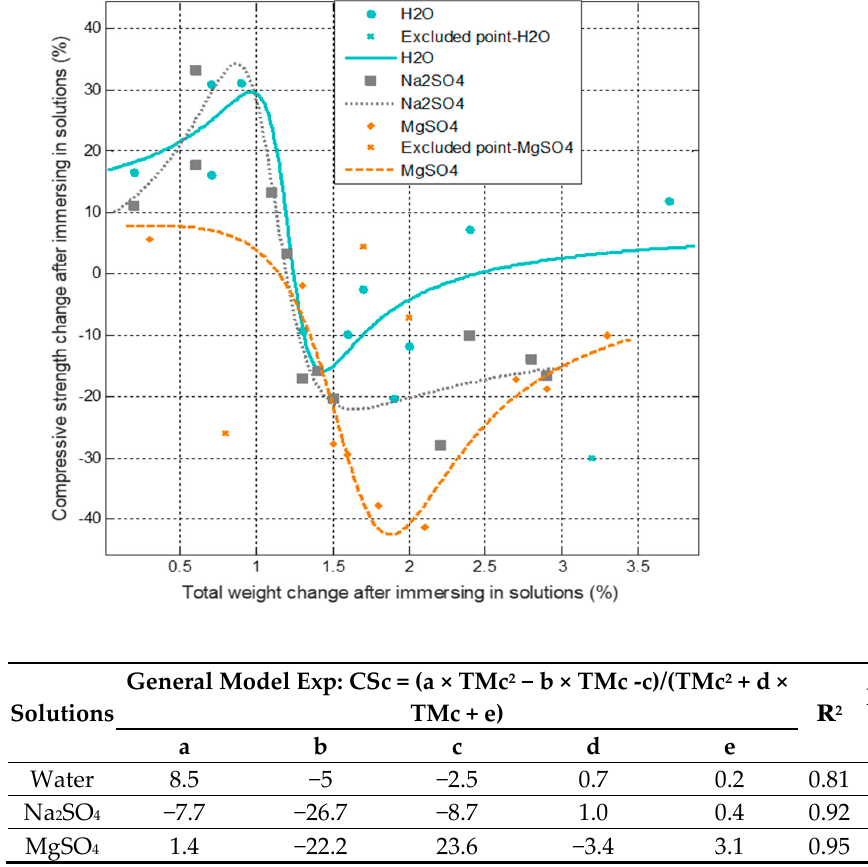
Figure 10. Compressive strength change (%) against total mass change (%) after immersion in solutions.